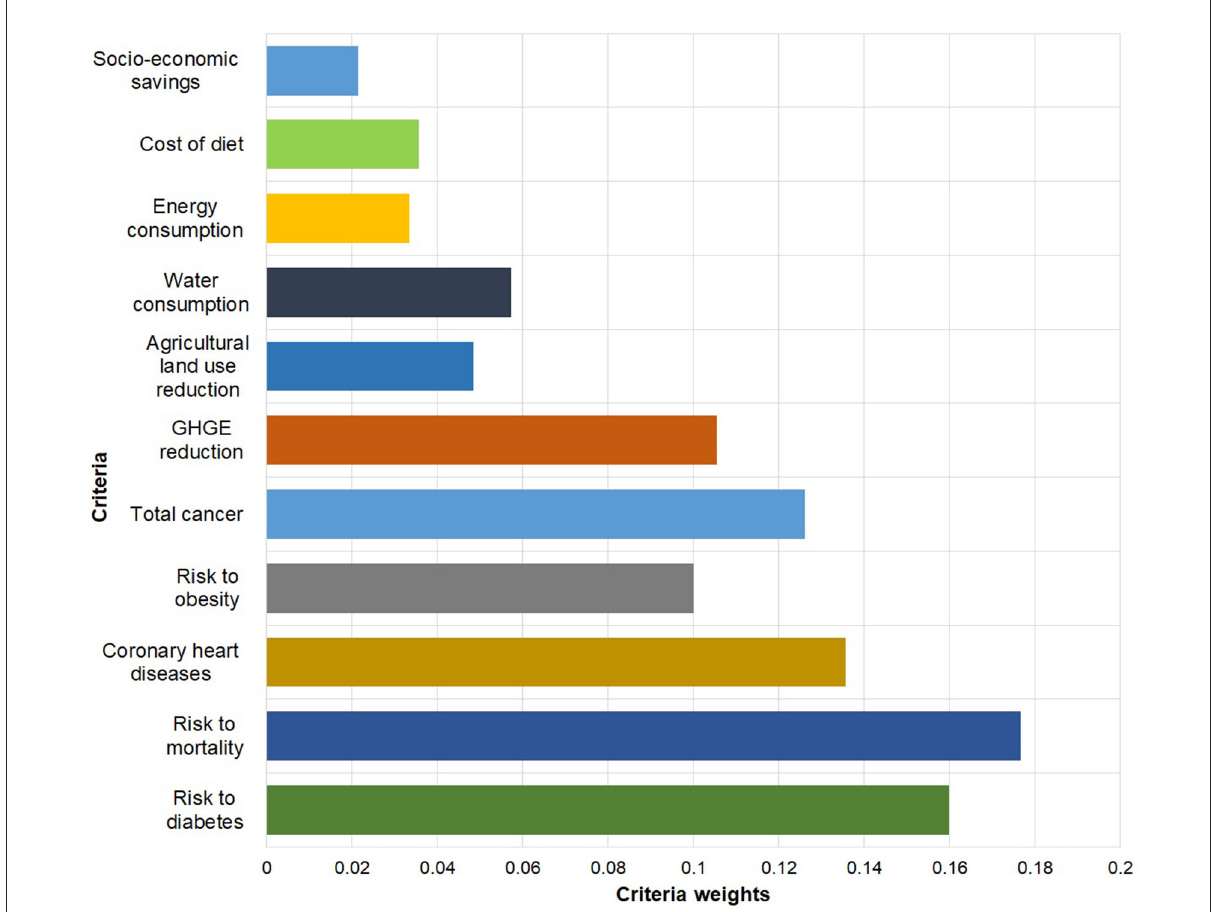
FIGURE8 Weights of importance of criteria adopted to evaluate sustainable diet